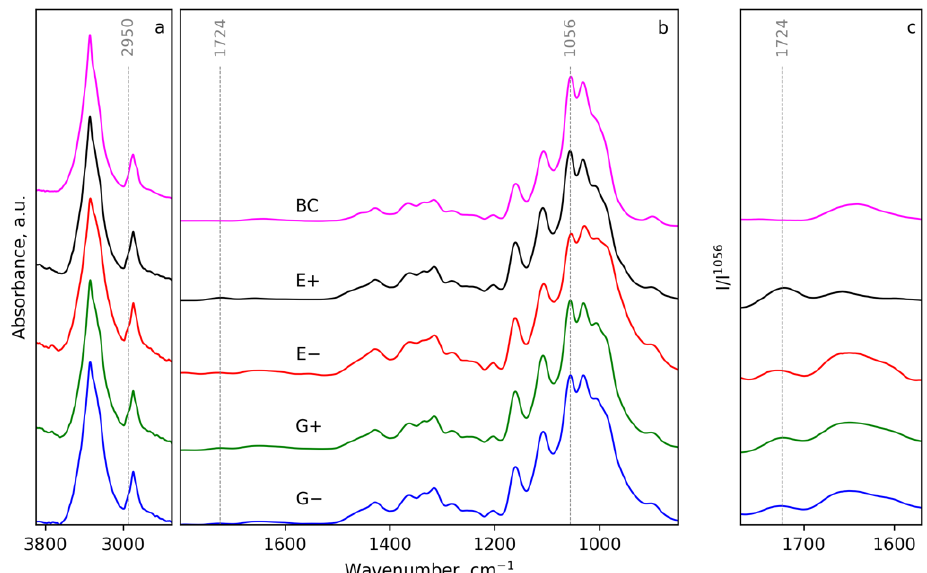
Figure 3. FTIR spectra of initial BC and BC-NFs prepared under different conditions in regions 3900–2500 cm − 1 ( a ), 1800–850 cm − 1 ( b ) and 1780–1570 cm − 1 , normalized with the intensity of absorption at 1056 cm − 1 ( c ).